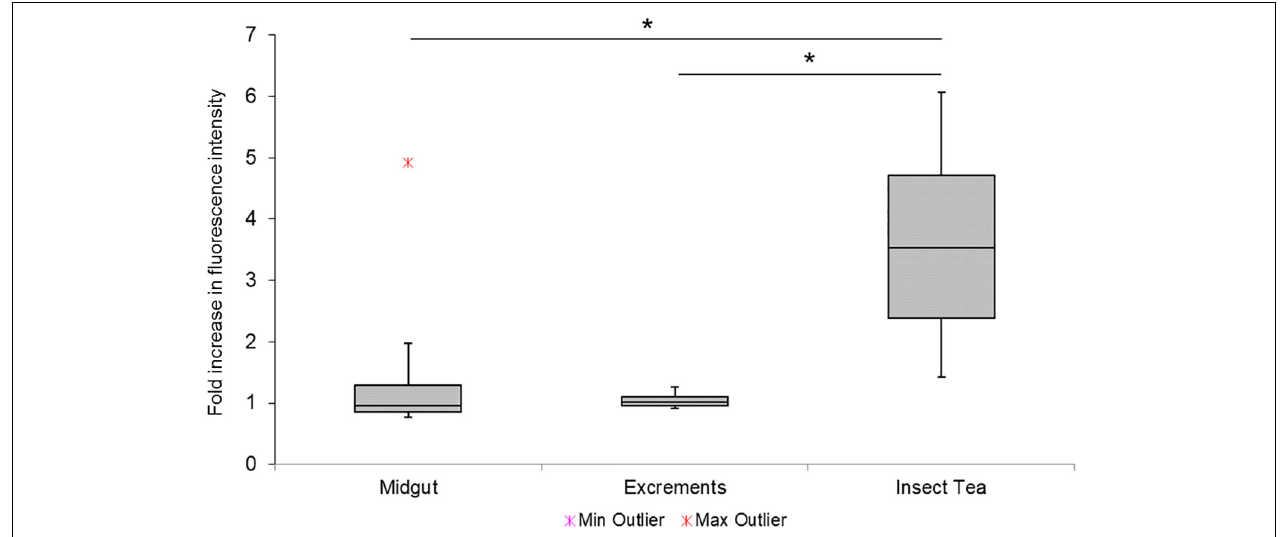
FIGURE 6 | Complementary assessment of Enterobacteriaceae during different process steps. The enrichment of Enterobacteriacea was confirmed with a complementary qPCR-based approach. The relative fluorescence signal increase in different samples was assessed with group-specific primers, and the fold increase was calculated by using the initial substrate ( C. paliurus leaves) as an internal reference. Minimum and maximum values are indicated by the whiskers, while outliers are separately shown. Statistical significance ( p < 0.05) is indicated with a black